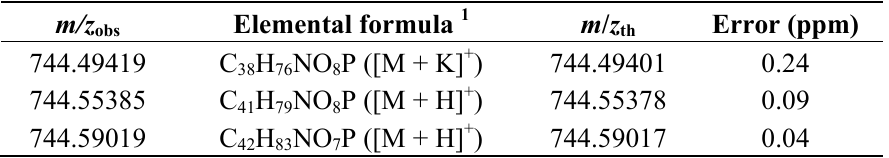
Table 3. Elemental formulas of minor PL species ( m/z 744.49419, 744.55385, and 744.59019) detected during MALDI MSI analyses.